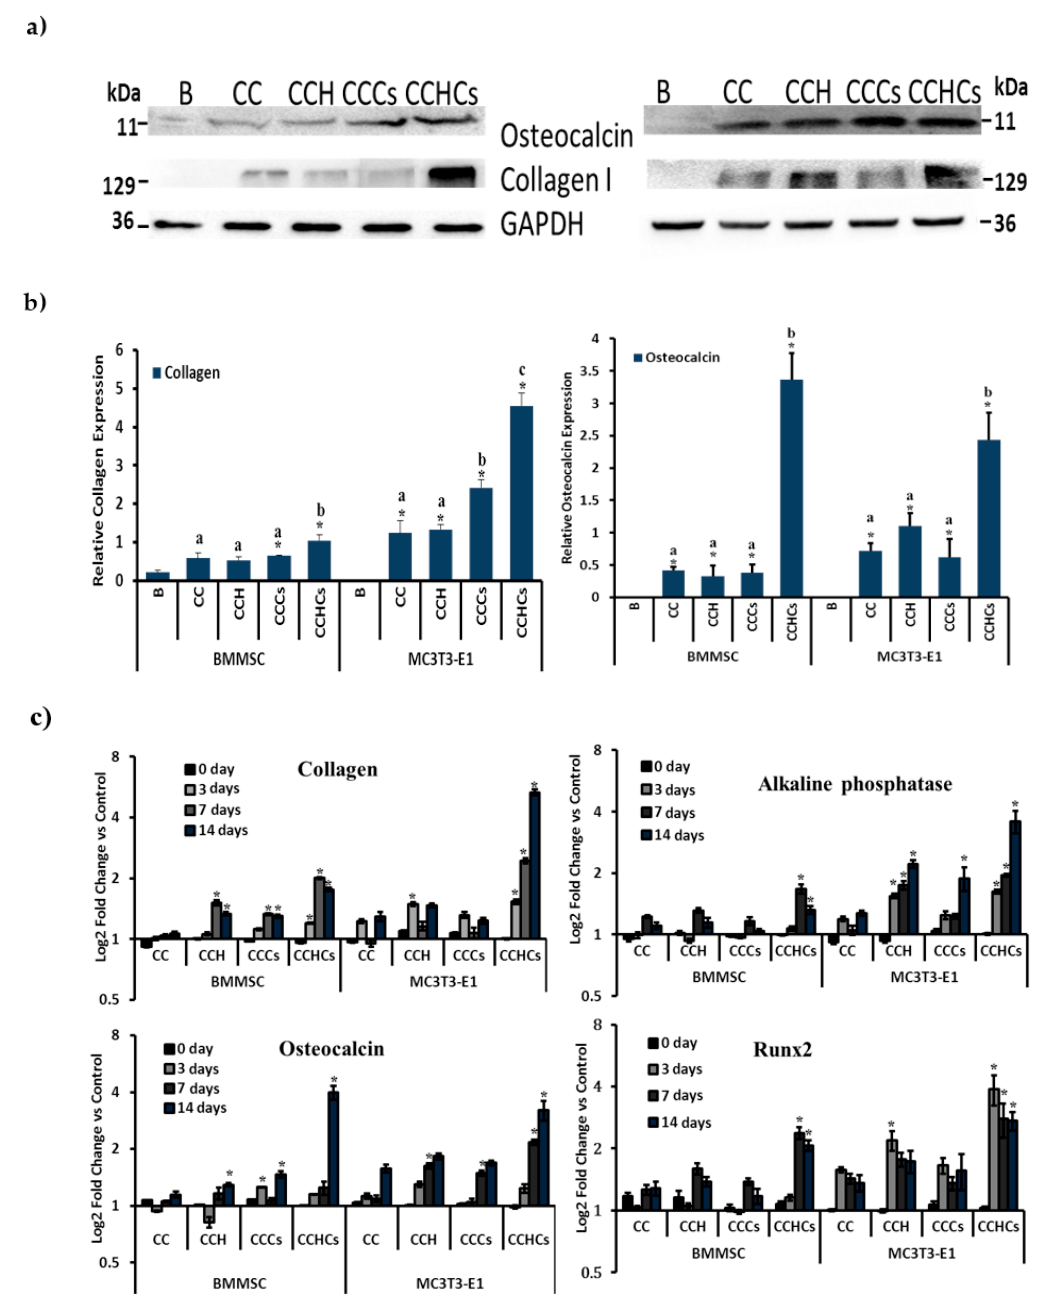
Figure 7. Protein ( a , b ) and mRNA expression ( c ) of bone cells. ( a , b ) Western blot analysis of collagen I and osteocalcin proteins expressed in bone cells. GAPDH was a loading control. ( c ) Osteogenic mRNA expression of di ff erentiated bone cells cultured in 3D matrices. mRNA expression of bone cells was normalized with GAPDH. Blank (B)-cells cultured in a six-well culture plate. Expression of osteogenesis regulatory mRNA was normalized with GAPDH of bone cells cultured at di ff erent times (0, 3, 7, and 14 days). BMMSC: bone marrow-derived mesenchymal stem cells; MC3T3-E1, pre-osteoblast. CC: chitosan-collagen 3D matrix, CCH: chitosan-collagen-hydroxyapatite 3D matrix, CCCs: chitosan-collagen-chondroitin sulfate 3D matrix, and CCHCs: chitosan-collagen-hydroxyapatite-chondroitin sulfate 3D matrix. Data are from the experiment repeated thrice with similar results; * p < 0.05 vs. blank ( b ); * p < 0.05 vs. CC ( c ); different letters indicate statistical significance among 3D matrices.